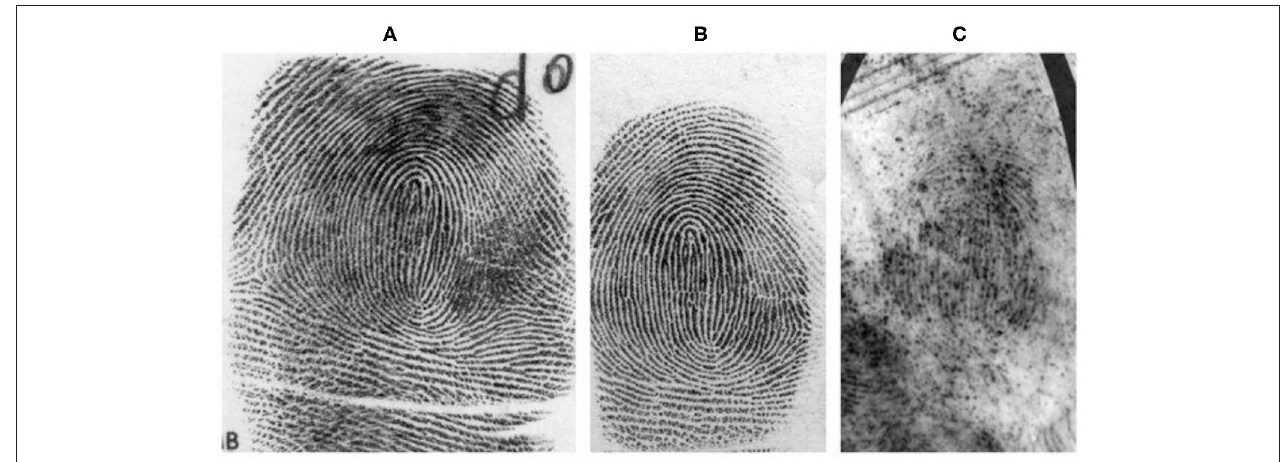
FIGURE 1 | Types of fingerprint images (Garris and Mccabe, 2000): (A) Rolled, (B) Plain obtained from scan method, and (C) Latent fingerprints of the same finger obtained from the crime